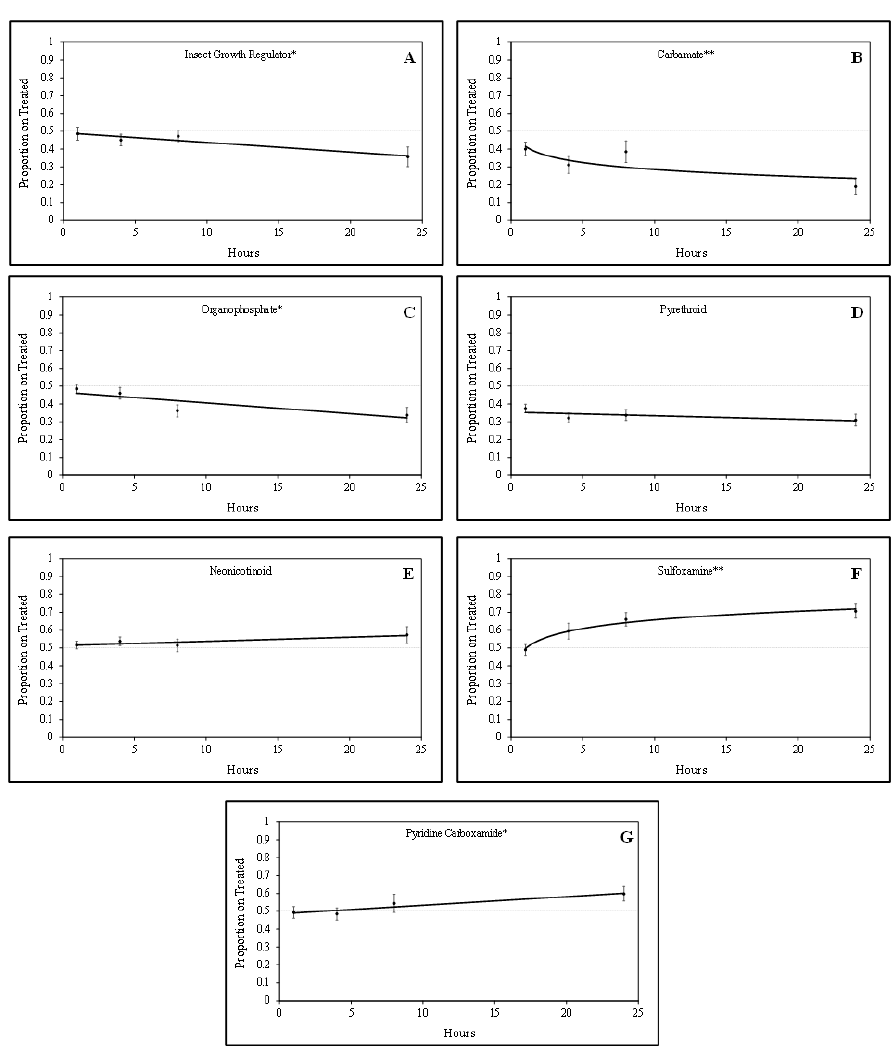
Figure 1. Relationship between the proportion of tarnished plant bug nymphs on treated green beans over time for various insecticide groups based on laboratory bioassays: ( A ) insect growth regulator; ( B ) carbamate; ( C ) organophosphate; ( D ) pyrethroid; ( E ) neonicotinoid; ( F ) sulfoxamine; ( G ) pyridine carboxamide; * significant linear relationship; ** significant quadratic relationship.